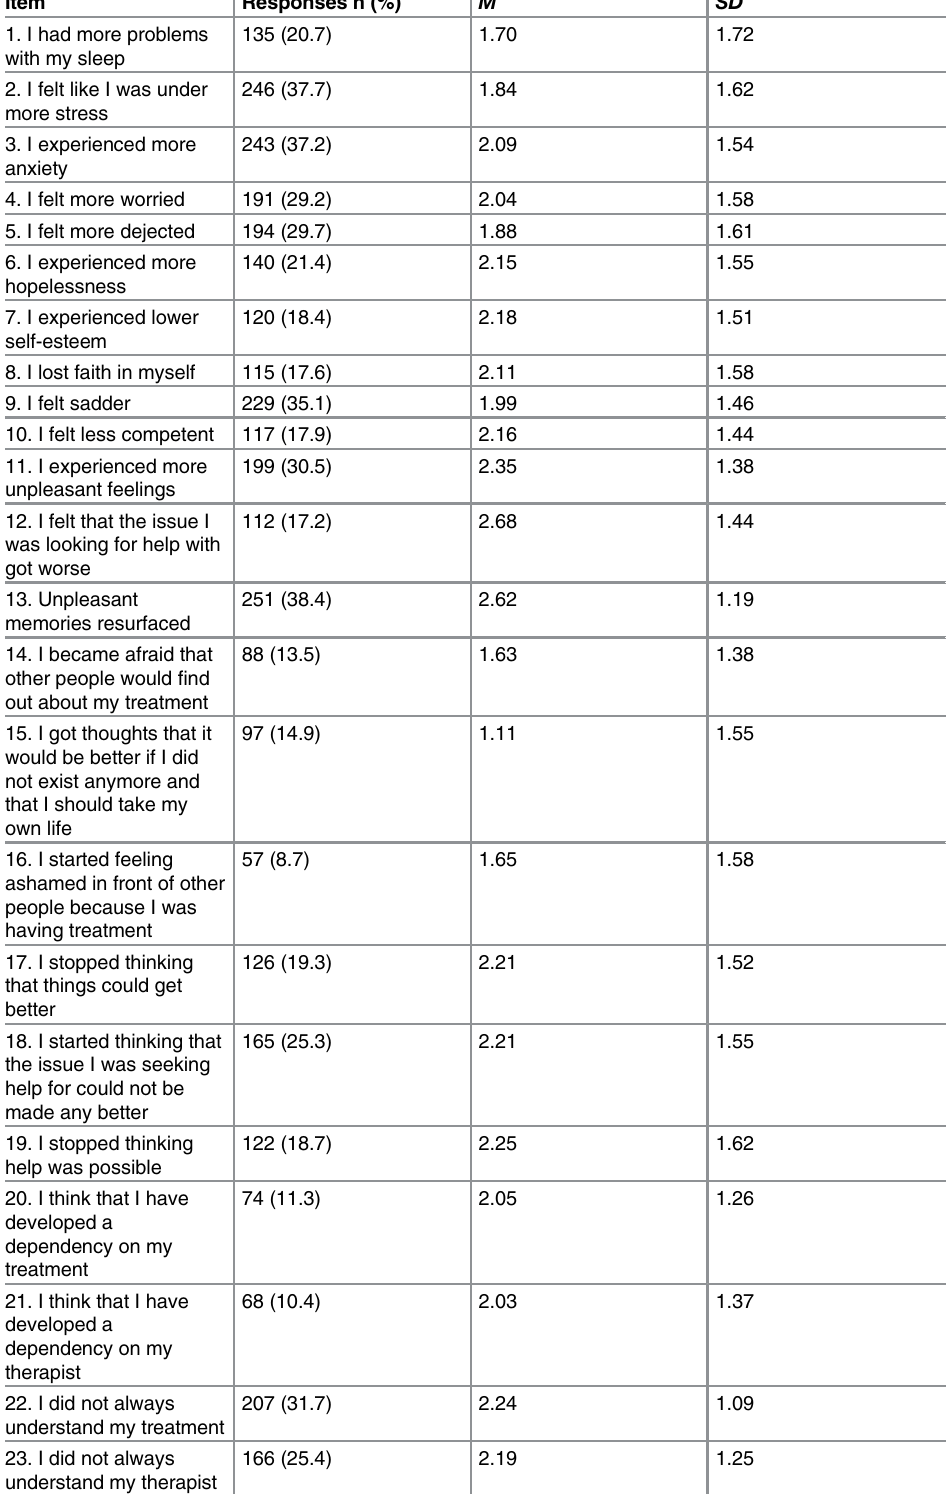
Table 5. Items, number of responses, mean level of negative impact, and standard